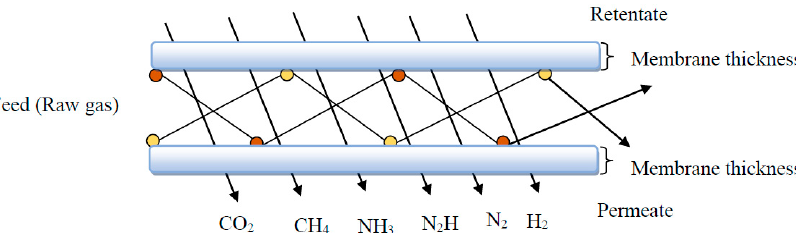
Figure 3. Schematic illustration of the membrane separation process using polymer membrane with selective inter-activities of the gas molecules with the pores across the membranes with the aid of Knudsen’s diffusion.